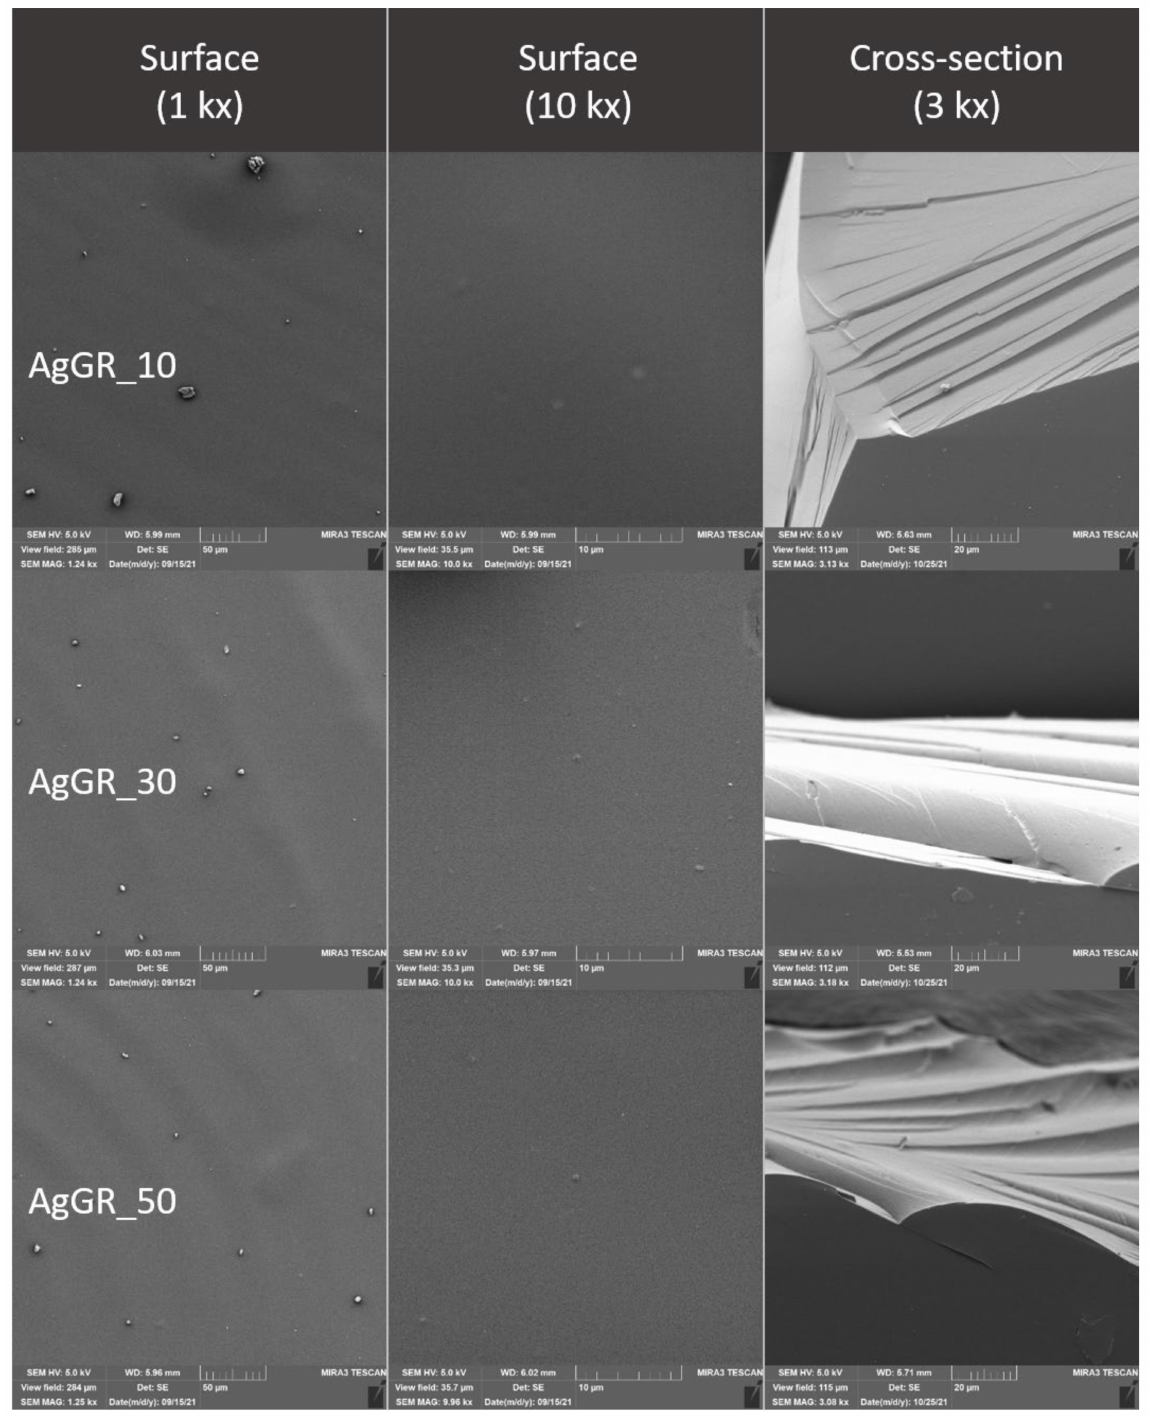
Figure 10. Surface and fracture microstructure of edible packaging with the addition of colloidal silver nanoparticles and grape